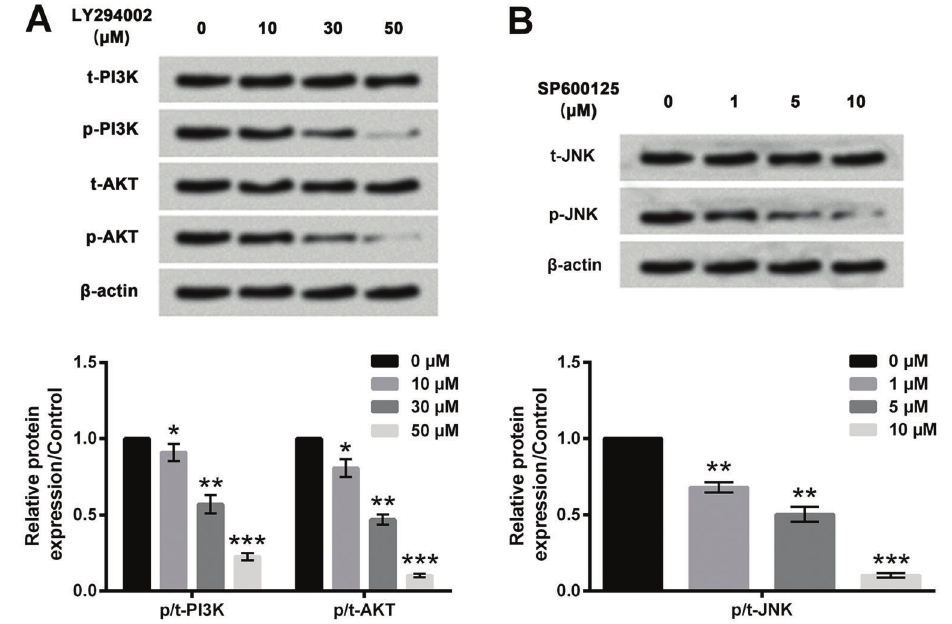
Figure 4. Stimulation with LY294002 ( A ) or SP600125 ( B ) for 1 h inhibited the PI3K/AKT pathway or JNK pathway in HaCaT cells, respectively. Expression of key kinases in the PI3K/AKTand JNK pathways were tested by western blot. Data are reported as means ± SD of three independent experiments. *P o 0.05, **P o 0.01, ***P o 0.001 compared to control